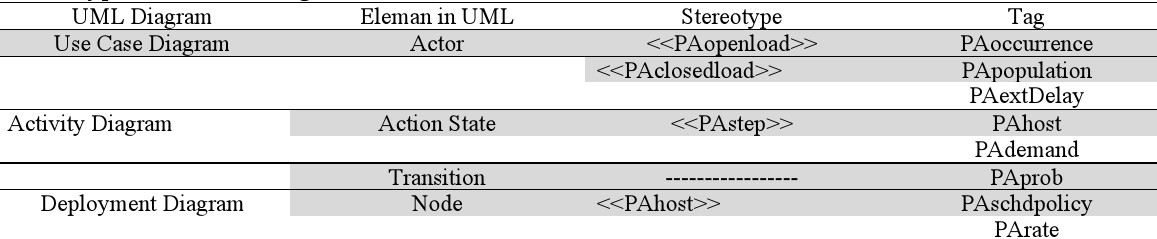
Stereotypes and related